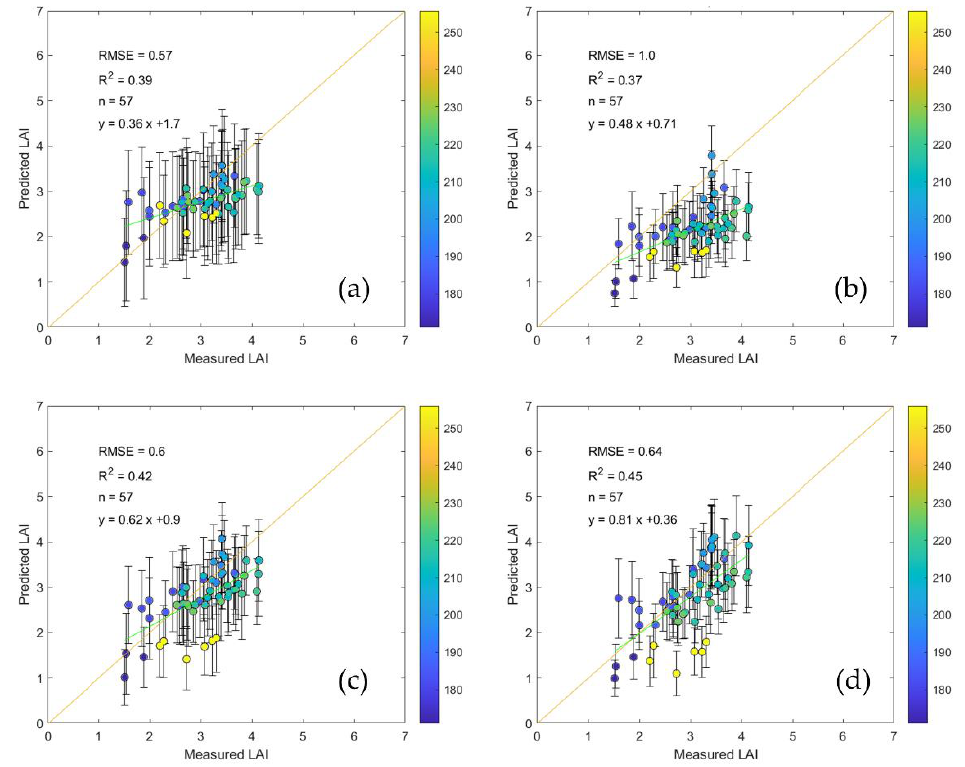
Figure 9. Comparison of LAI measured in situ and that estimated from reflectance-based LUT from Sentinel-2 data. The spectral bands used for inversion correspond to ( a ) G; ( b ) R, and NIR; ( c ) red-edge 1 and NIR; ( d ) red-edge 1, red-edge 2 and red-edge 3. Error bar represents the standard deviation of LAI retrievals. Color bar represents DOY (i.e., day of year) of images.